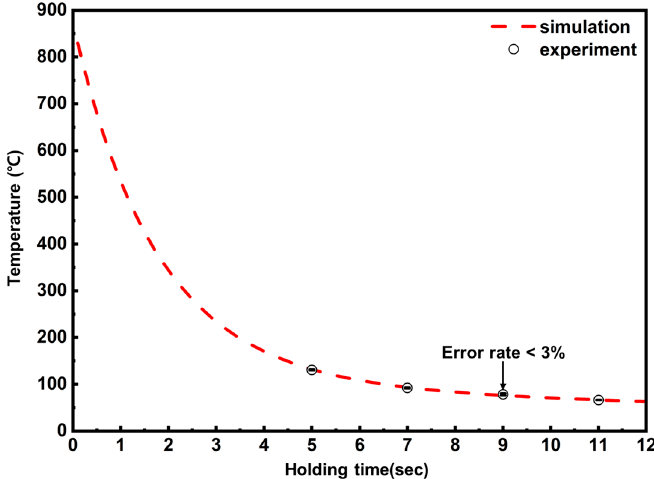
Figure 11. Temperature change of the blank made by the slice die.